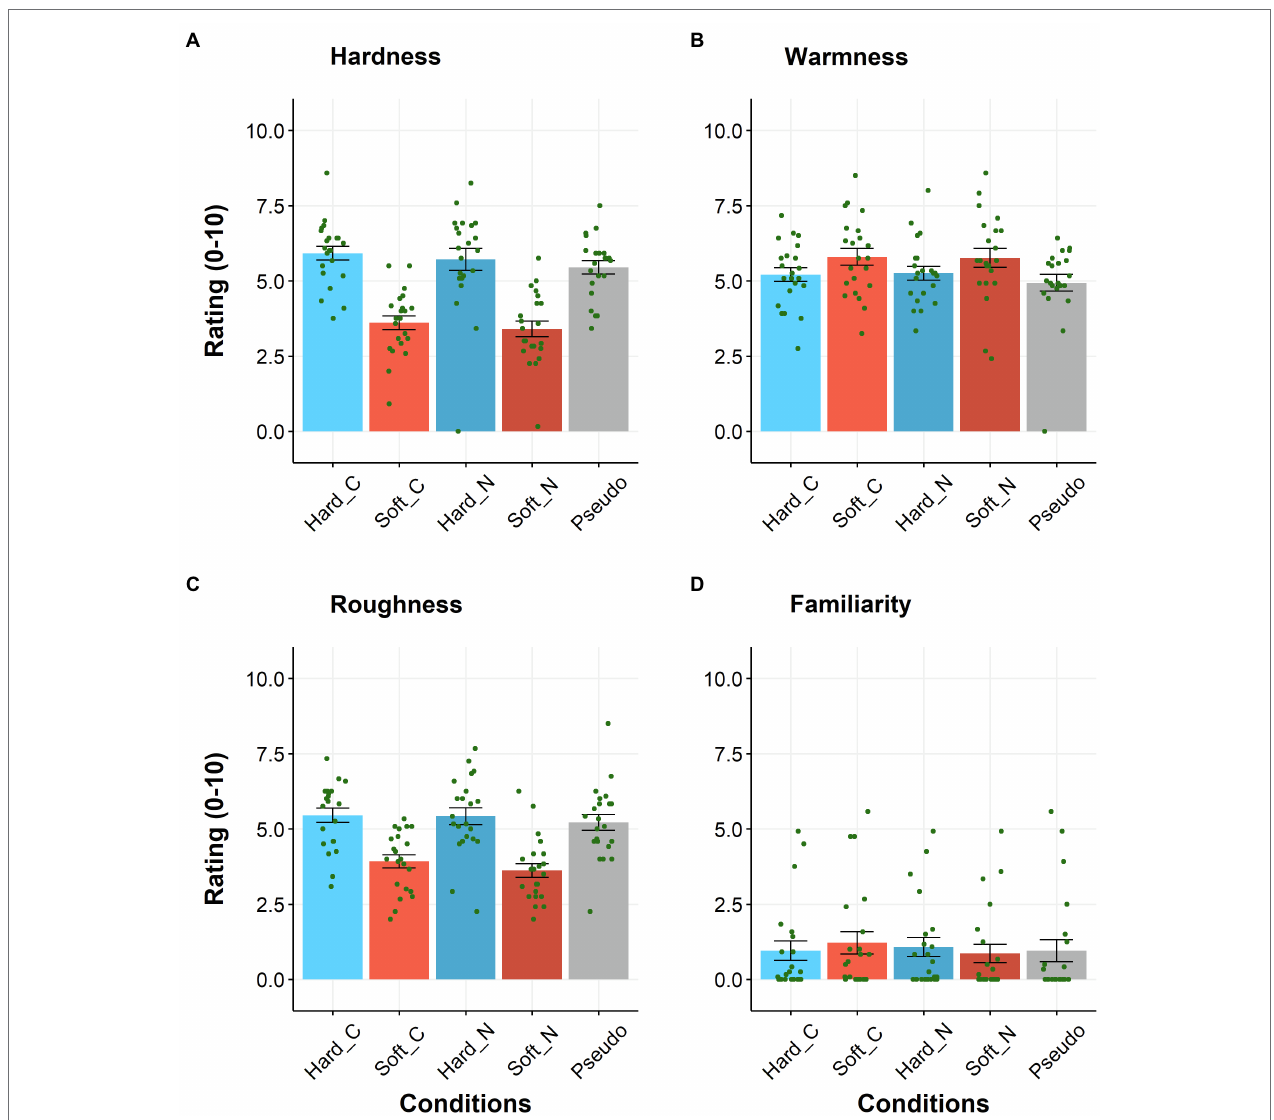
FIGURE 2 | Singaporean subjects’ ratings for hardness (A) , warmness (B) , roughness (C) , and familiarity (D) . Hard_C, Soft_C, Hard_N, Soft_N, and Pseudo indicate conventional “hard,” conventional “soft,” novel “hard,” and novel “soft” words, as well as non-sound-symbolic pseudowords, respectively. N = 22. Error bars indicate SEM, and each dot indicates each subject’s